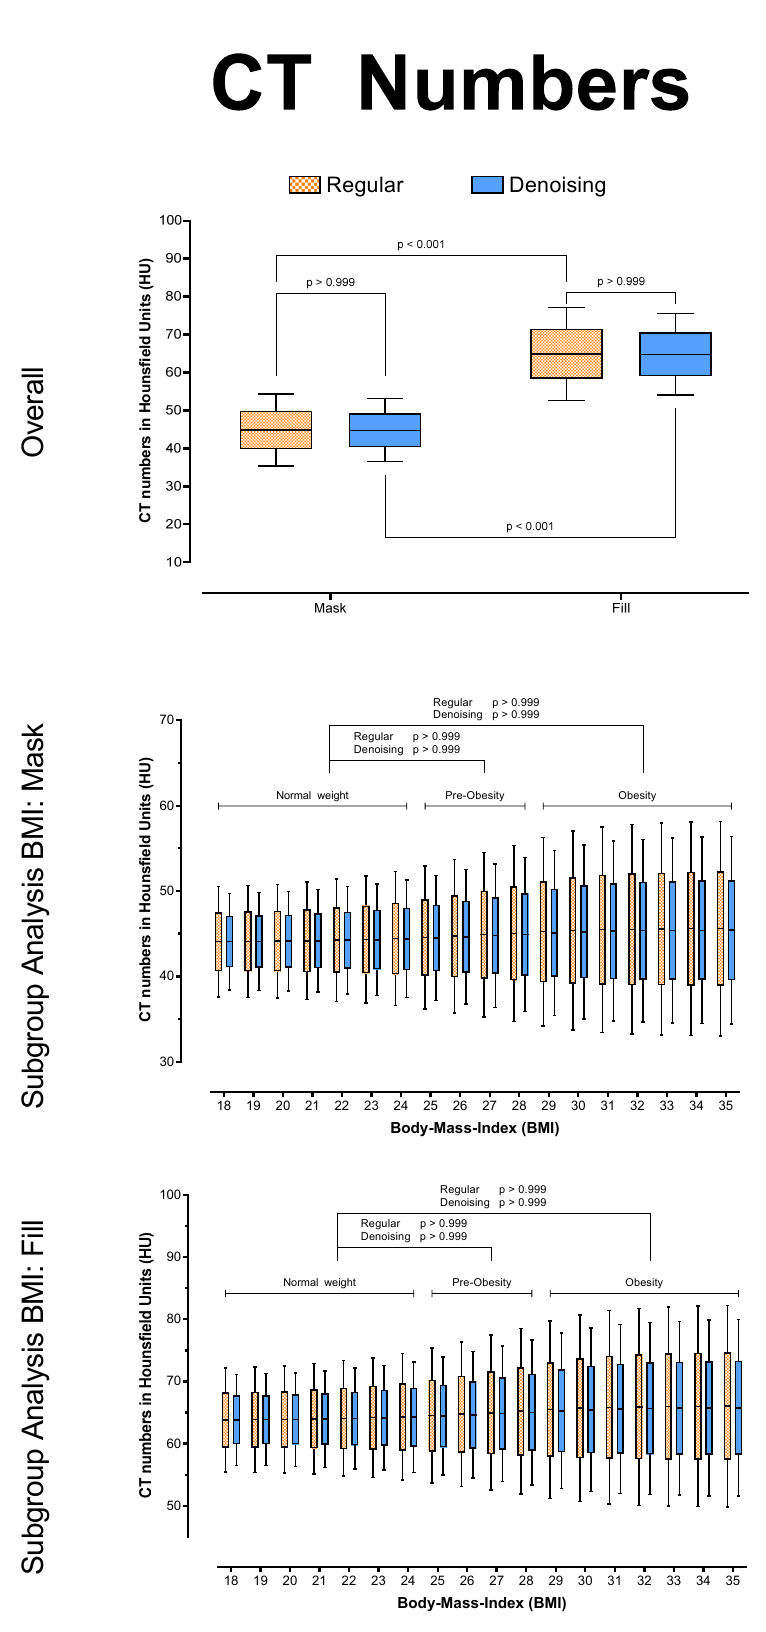
Figure 3. CT numbers in HU, overall and posthoc subgroup analysis for patient BMI.